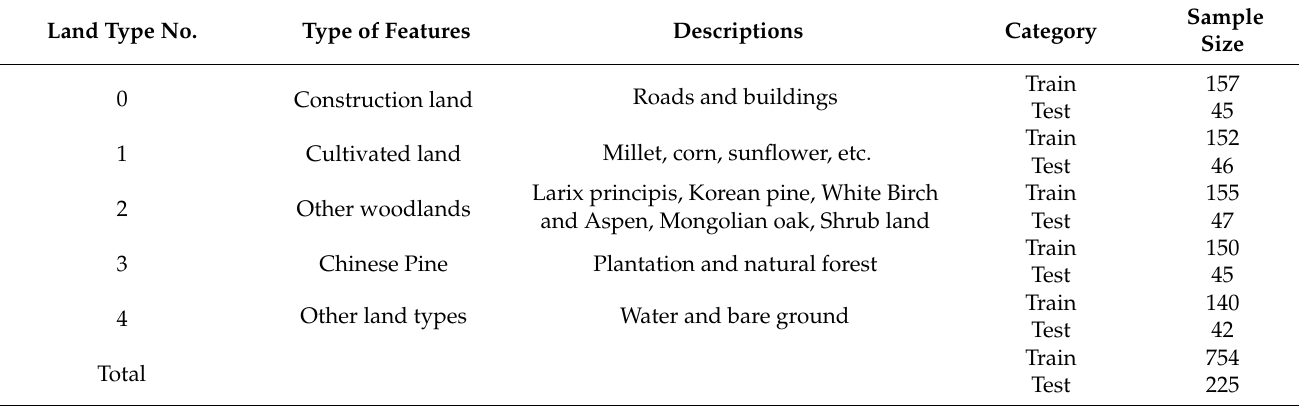
Table 3. Sample data used in this